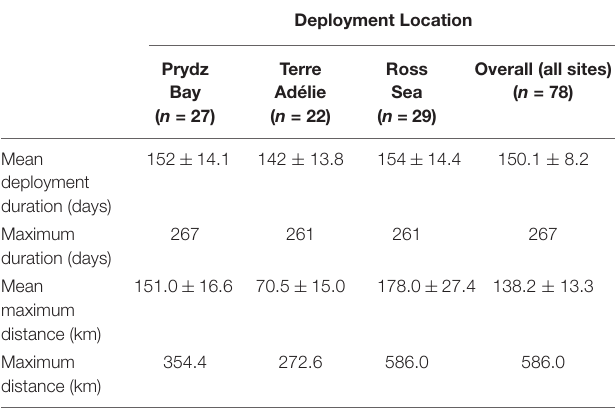
TABLE 1 | Summary statistics (mean ± s.d.) of tracking data from Weddell seals and three deployment locations during the winter months. Deployment